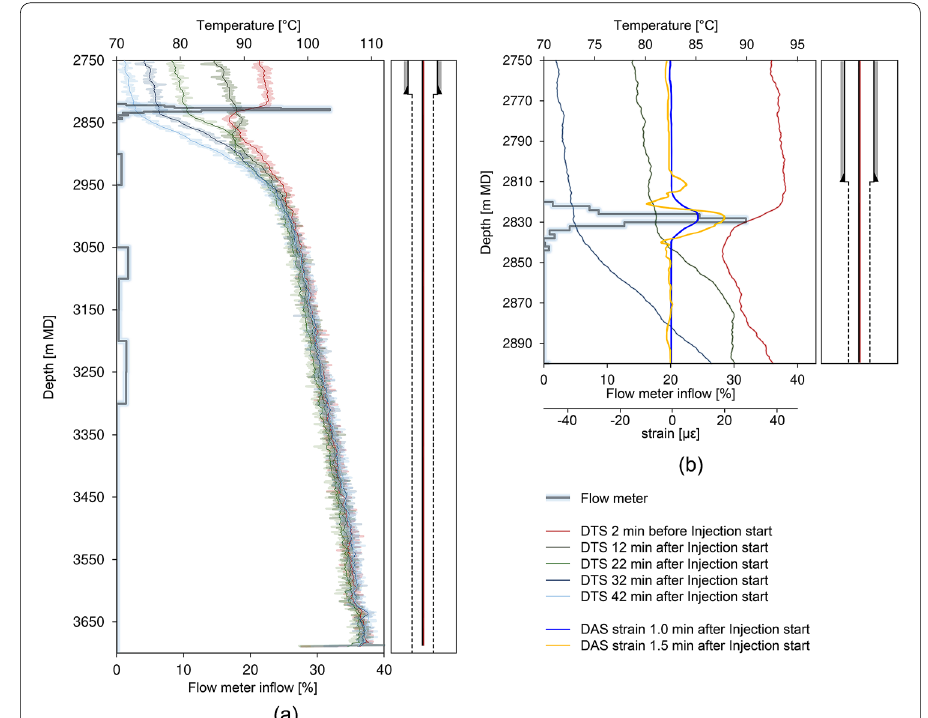
Fig. 14 Comparison of flowmeter injection profile and DTS and DAS response during Inj2. Transparent lines are raw DTS data, sharp lines are moving average over 10 m. a Flowmeter profile with five DTS profiles in the first hour of cold water injection over from 2750 m MD to TD. b Zoomed to top of the reservoir. Flowmeter profile is shown together with three DTS profiles of injection start, each 20 min apart; and DAS strain at 1 min and 1.5 min after injection